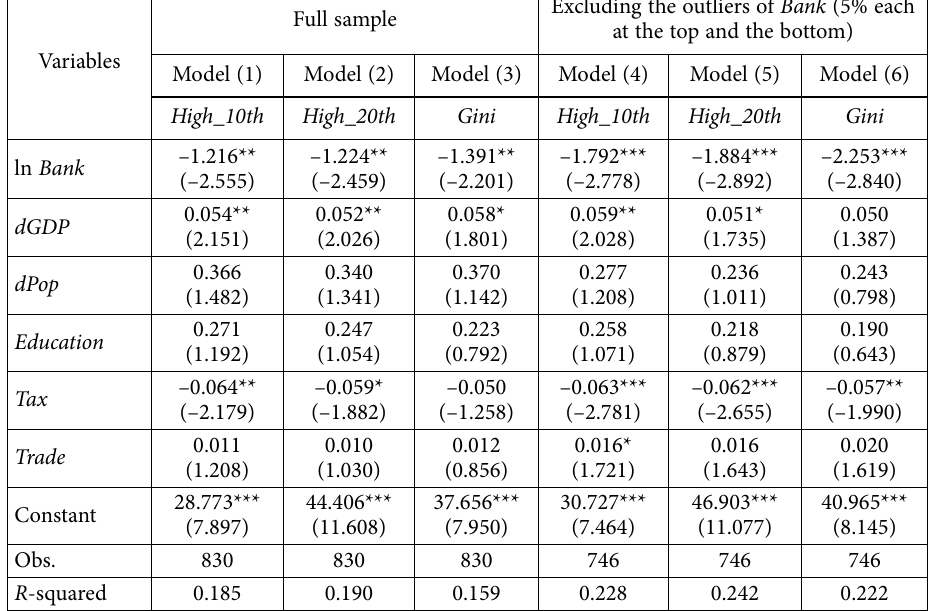
Table 2. Results of benchmark